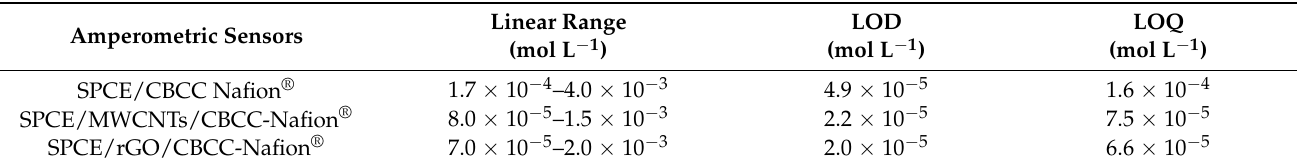
Table 1. Comparison of the prepared amperometric sensors integrated into wall-jet flow cell in FIA of hydrogen peroxide. Amperometric